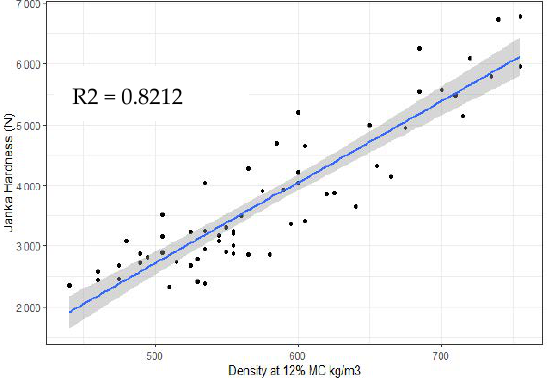
Figure 7. Correlation between Janka hardness and density for sawlog E. nitens .